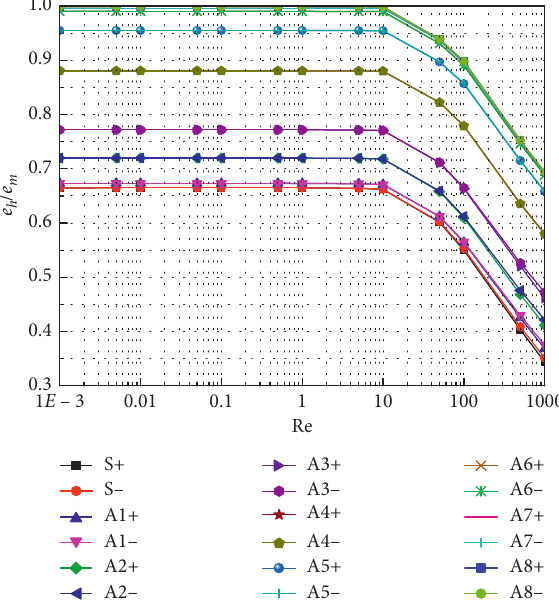
Figure 4: Variation of the relative hydraulic aperture e Reynolds number under different decomposition levels in the approximate profile models (Ai+ and Ai − represent the calculation results of model Ai in the forward and reverse directions,